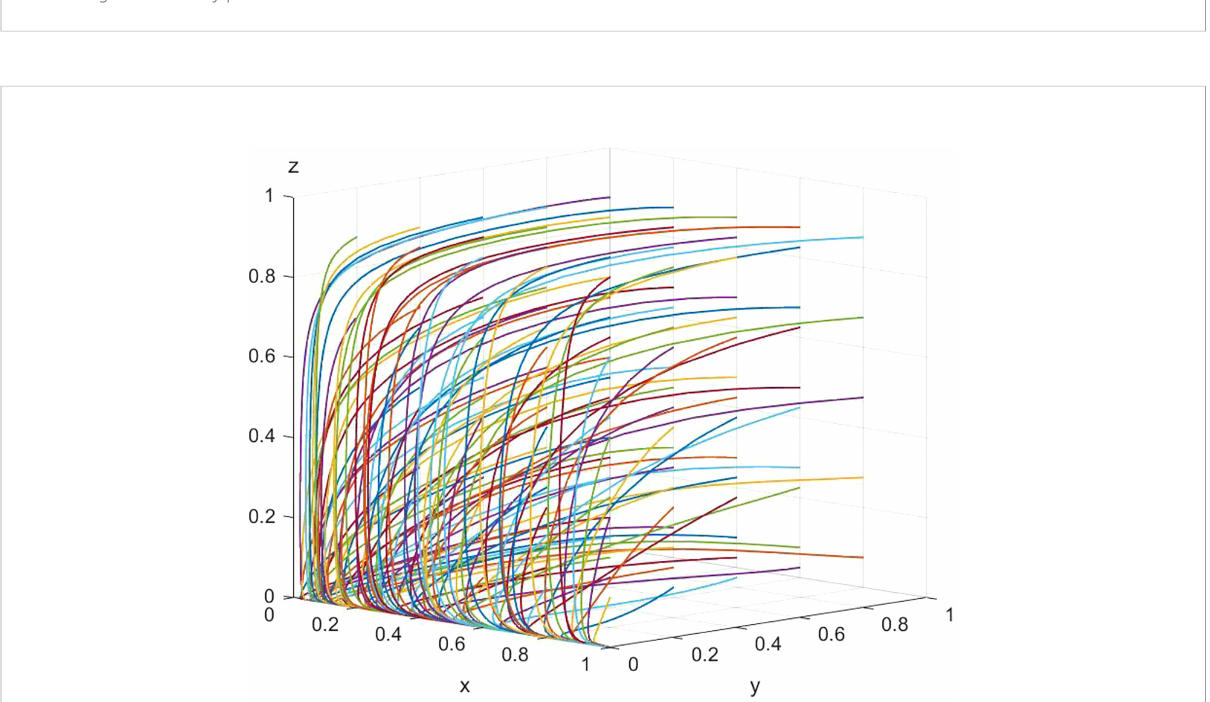
FIGURE 1 Initial stage evolutionary path.